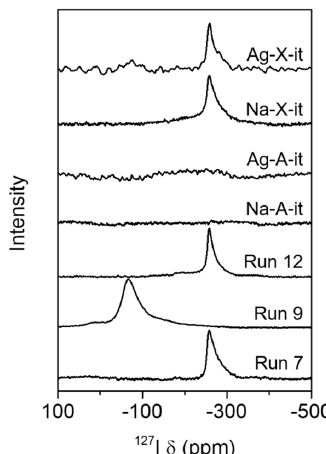
Figure 4. 127 I MAS NMR spectra of the representative products synthesized by the interzeolite transformation of Na-A and Na-X, and the interzeolite transformation products of CH 3 I adsorbed Na-A, Ag-A, Na-X, and Ag-X.